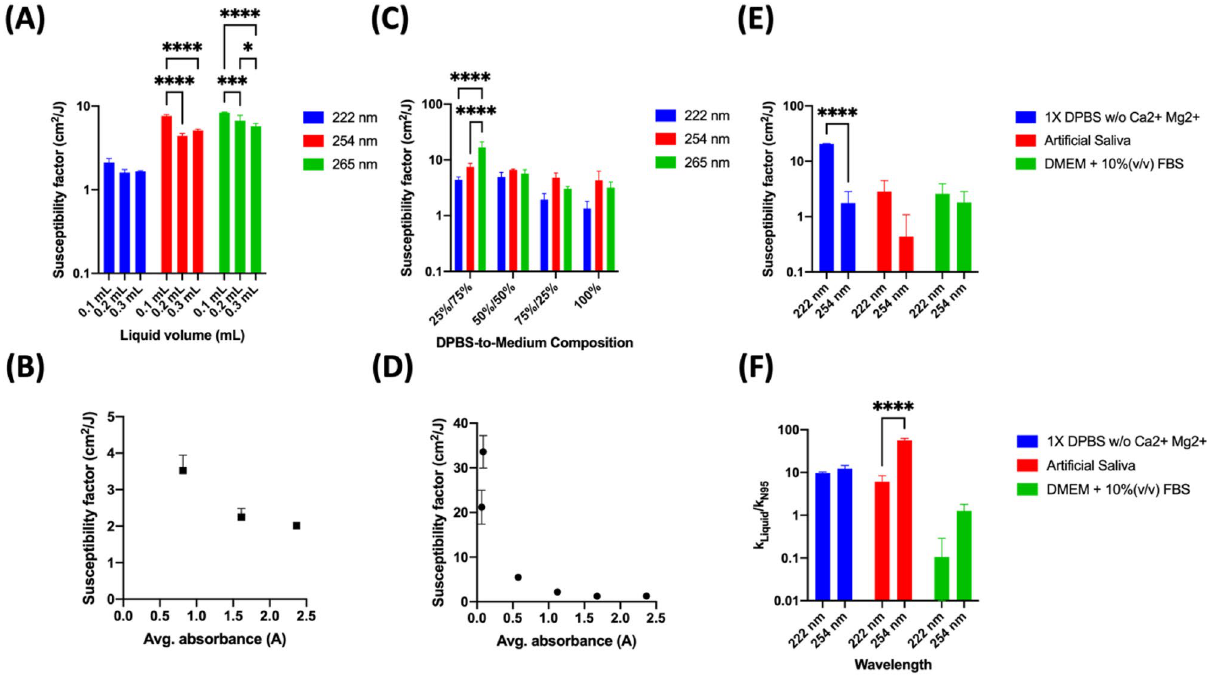
Figure 5. Environmental effect on virus UVC susceptibility. ( A ) Viruses suspended in DMEM + 10%(v/v) FBS with different liquid depths created by adding different volumes (0.1, 0.2, and 0.3 mL) of virus suspension to a 96-well plate. Viruses were exposed to various does of 222 nm, 254 nm, or 265 nm UVC light from which susceptibility factors were calculated. p values < 0.05. ( B ) The correlation of virus susceptibility to liquid absorbance of UVC light at 254 nm. The 254 nm viral susceptibilities were negatively correlated to the measured liquid absorbance at the three liquid heights. ( C ) Mixtures containing different percentages of DMEM + 10%(v/v) FBS (25, 50, 75, and 100%) to DPBS were exposed to 222 nm, 254 nm, and 265 nm UVC light. ( D ) The 254 nm viral susceptibility factors were negatively correlated to the measured absorbances of the different mixtures. ( E ) N95 mask cut-out samples were contaminated with 10 µL of a concentrated viral suspension and then irradiated to 254 nm and 222 nm at various doses. Virus was significantly more